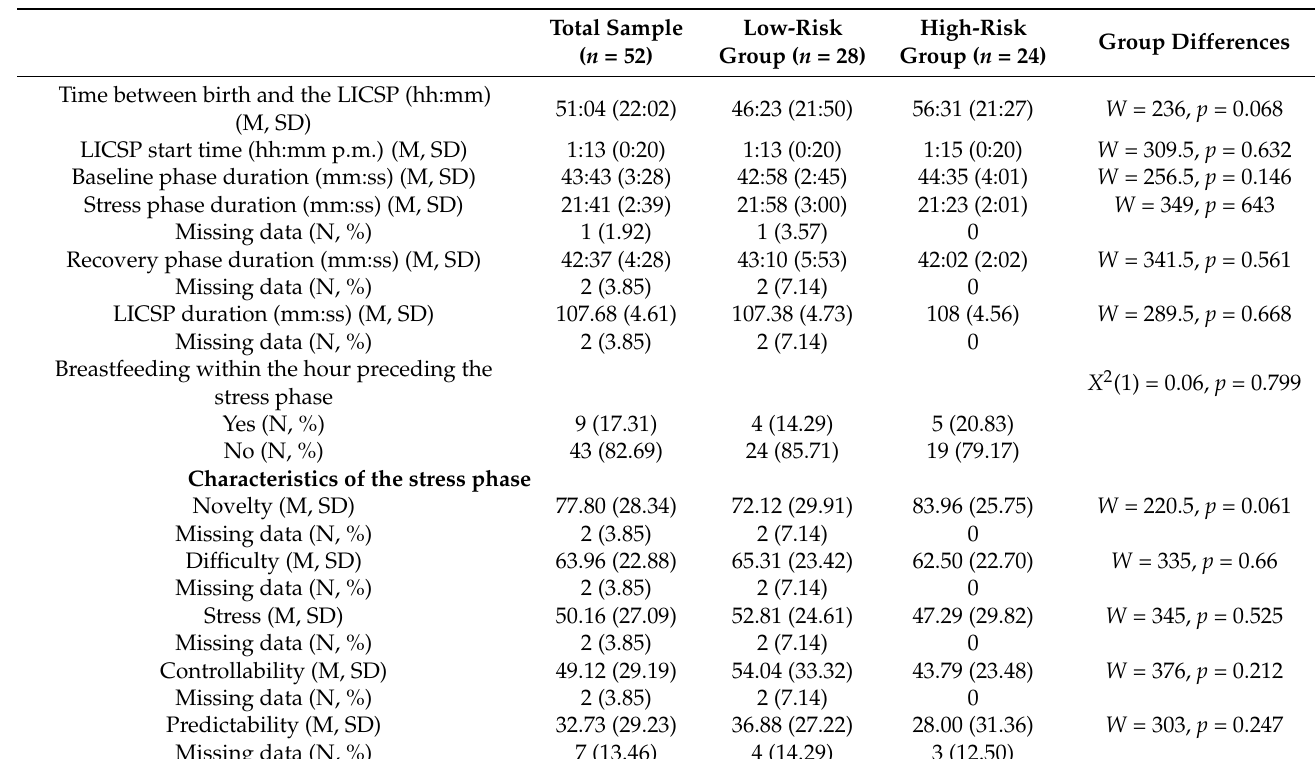
Table 3. Descriptive data of the Lausanne Infant Crying Stress Paradigm. Total